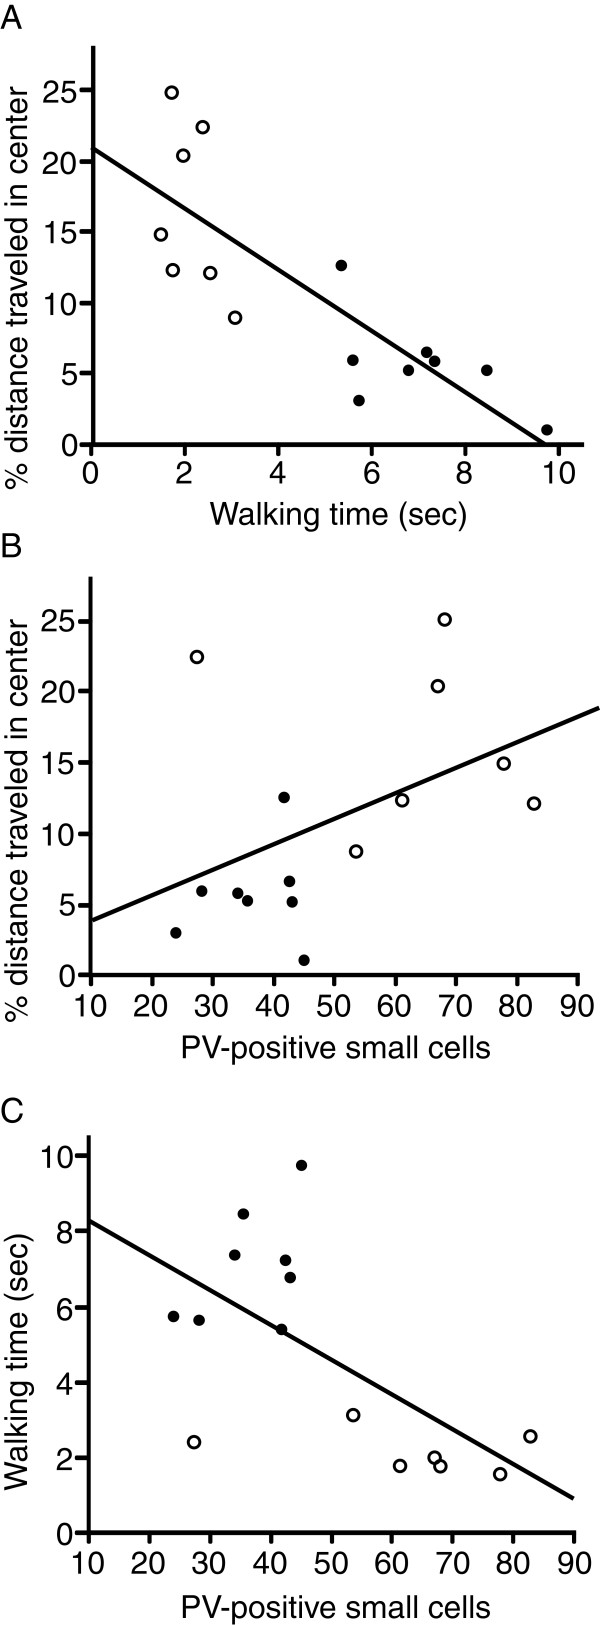
Relationship between behavioral alterations (open field and beam walking tests) and PV-positive cells in BLA. Simple regression analysis indicated that walking time in the beam walking test was significantly and negatively correlated with the % distance traveled in the center arena in the open field test (A, p < 0.001). Simple regression analysis also revealed that the number of PV-positive small cells tended to be positively correlated with the % distance traveled in the center arena in the open field test (B, p = 0.078) and significantly and negatively correlated with walking time in the beam walking test (C, p < 0.05). Open circles, EE; closed circles, SE.